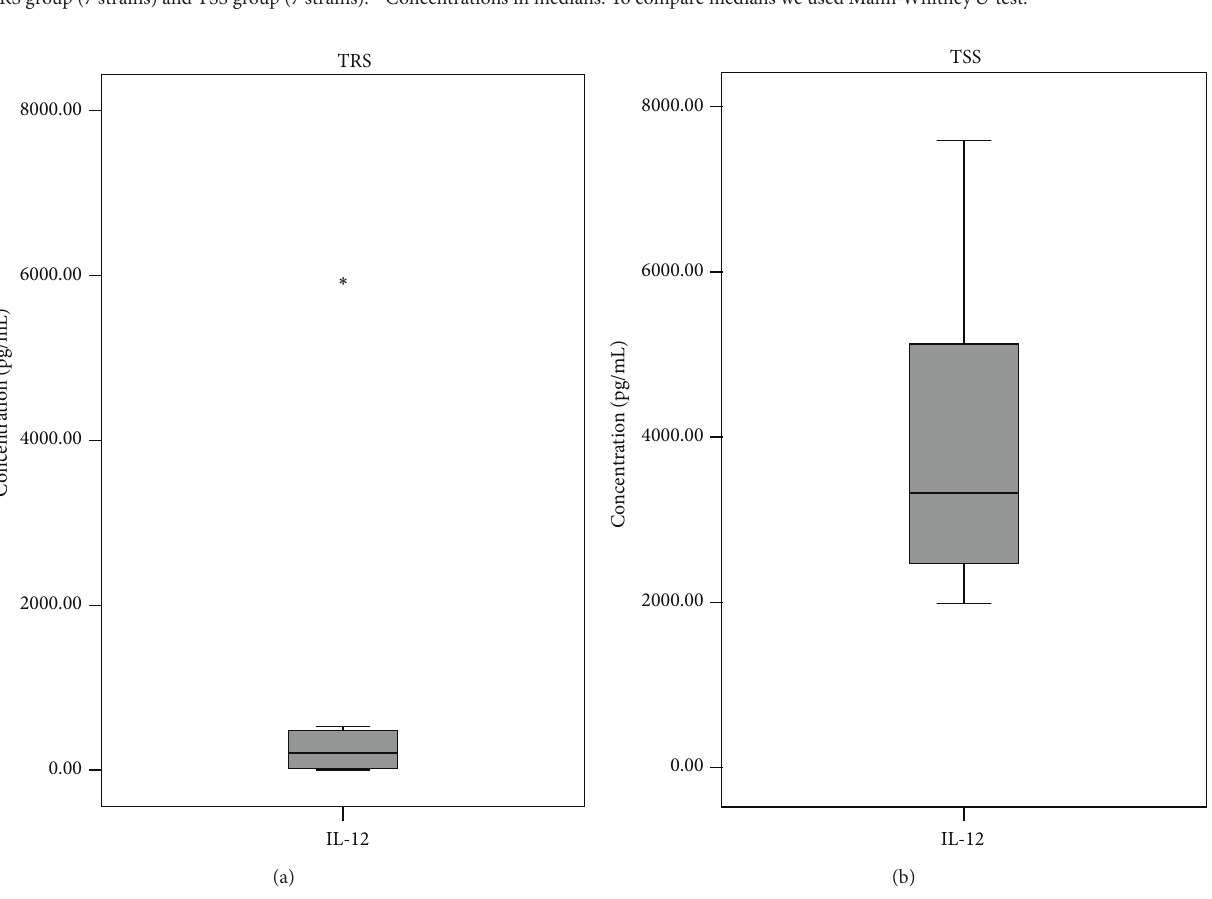
Figure 2: The concentration of IL-12 in pg/mL when THP-1 cells were stimulated with H. pylori therapy resistant strains (TRS) or H. pylori therapy susceptible strains (TSS). The difference is statistically